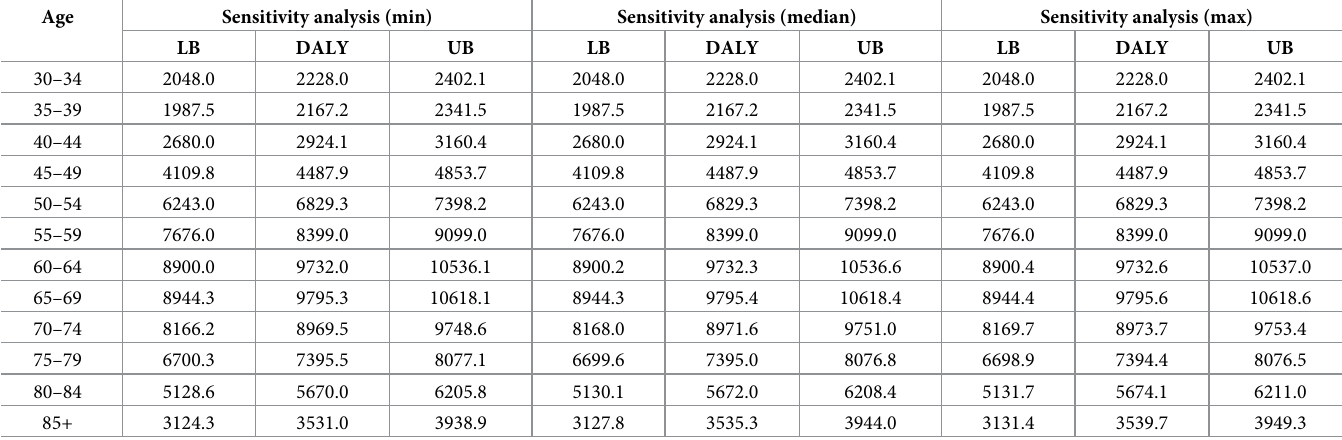
Table 4. Results of sensitivity analysis in